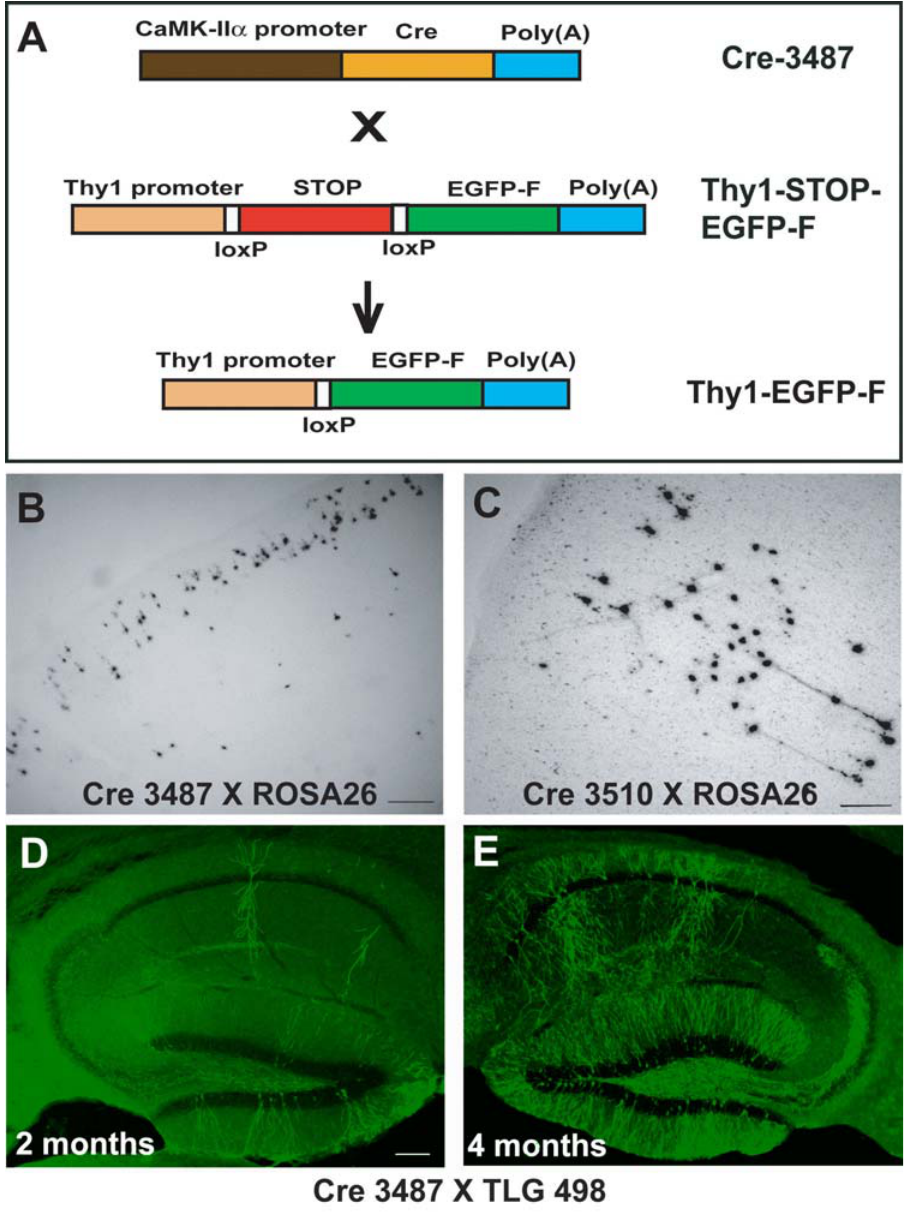
Figure 1. Generation of Cre-dependent mosaic transgenic mice. (A) Transgenic mice based on Cre/Lox recombination were generated by crossing a Cre-transgenic line under a CaMKII a promoter with a Thy1 promoter-driven EGFP-F transgenic line containing a transcriptional STOP cassette. Bright field microscopy images showing mosaic expression of the b -galactosidase expressing cells in layers II/III and V/VI of the neocortex of R26R mice when crossed with different CaMKII a promoter-driven Cre-transgenic lines – (B) Cre 3487 and (C) Cre 3510. Epi-fluorescence microscopy images of Cre-dependent EGFP-F expression in TLG 498 + Cre 3487 + transgenic mice. EGFP-F expression starts at 6 weeks and increases with age. The number of EGFP-F + cells increases from (D) 2 months to (E) 4 months of age. Scale bars: B, D-100 m m; C-200 m